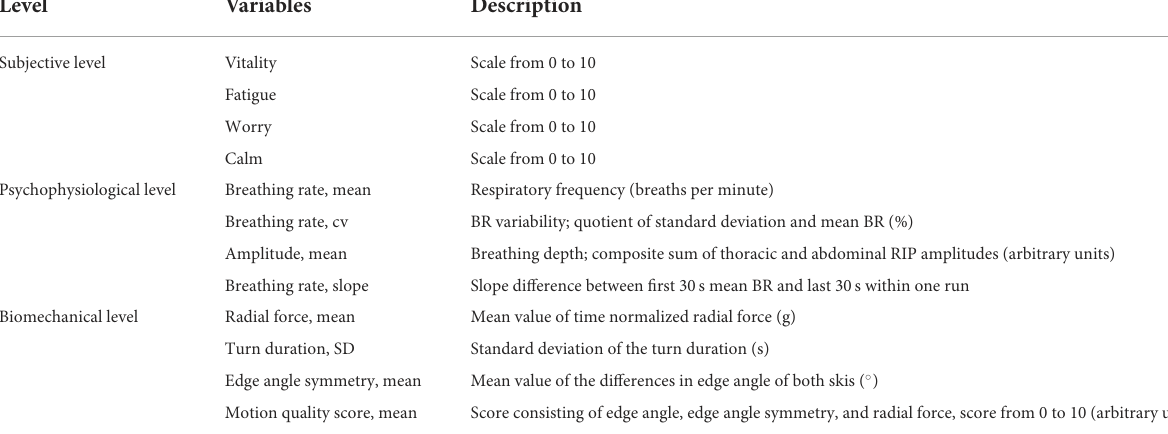
TABLE 2 Overview of the selected aiming